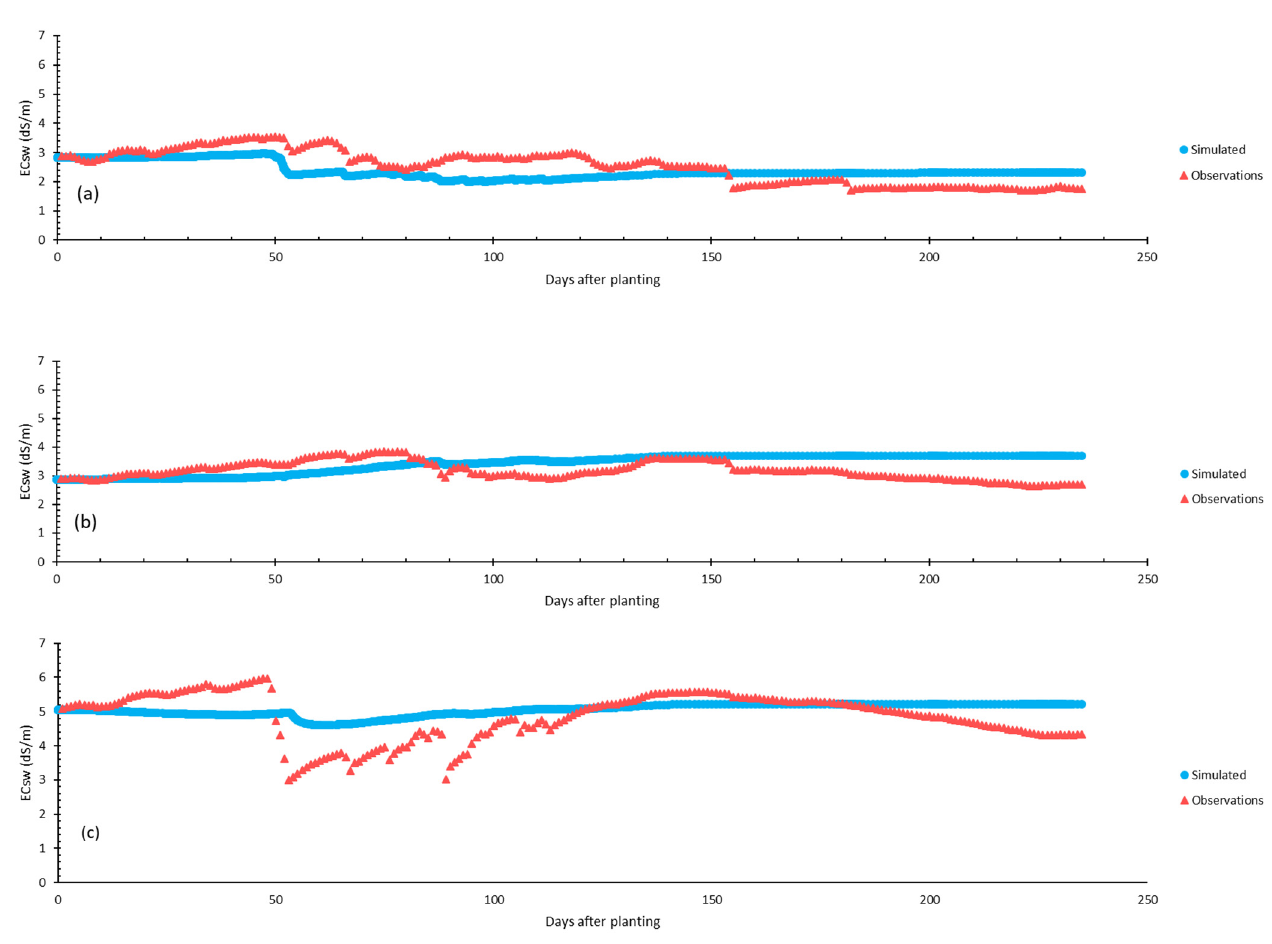
Figure 8. The simulated and observed electrical conductivity of soil water at ( a ) 16, ( b ) 46, and ( c ) 76 cm soil depths.